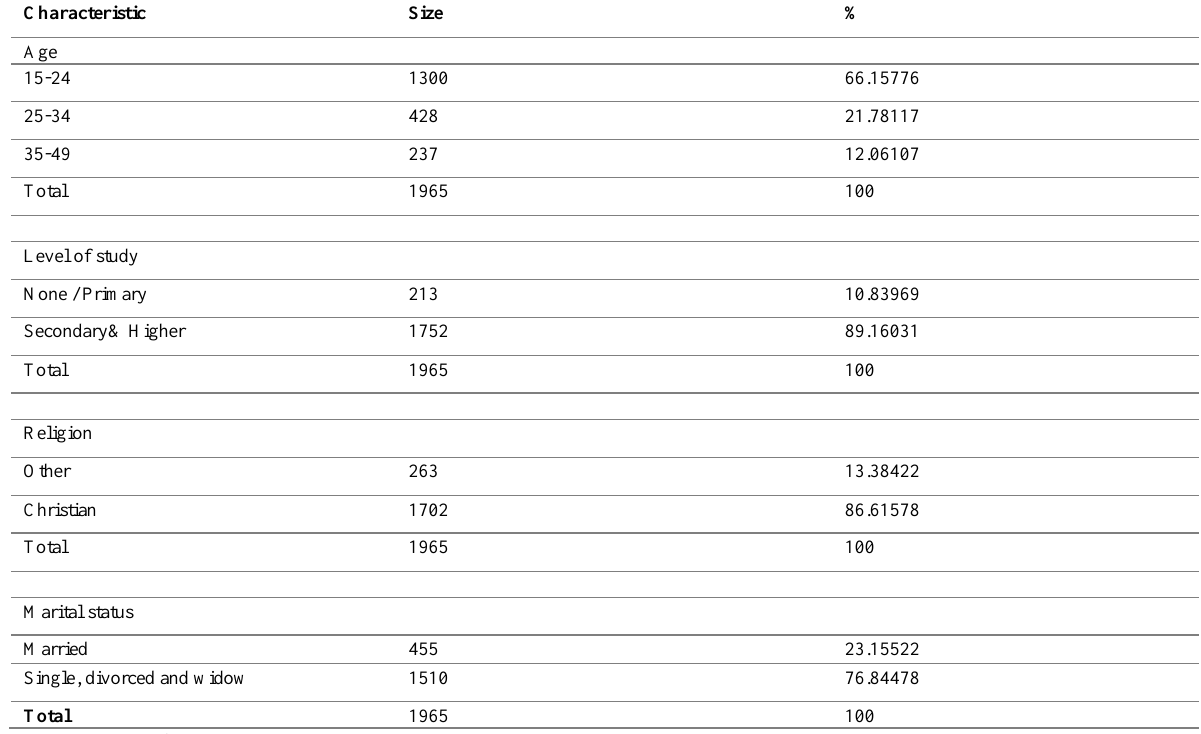
Table 1: Presentation of socio-cultural and socio-demographic variables